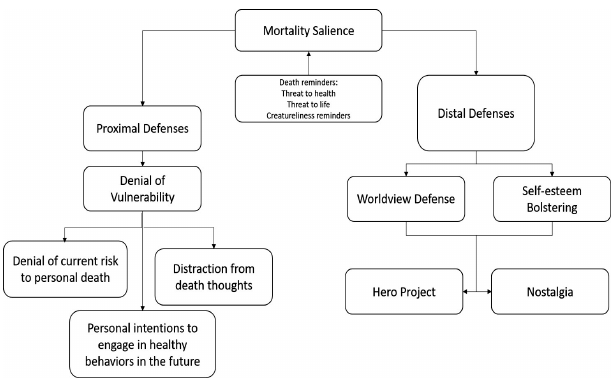
Fig. 1. The role of mortality salience in terror management